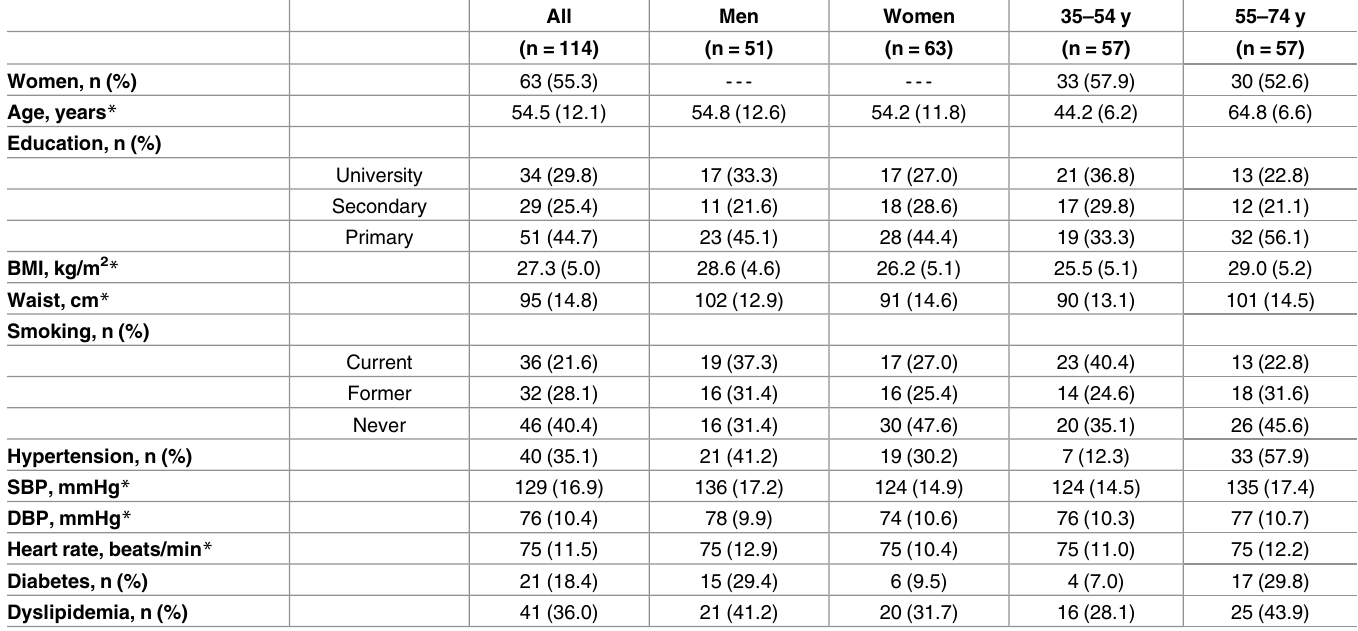
Table 2. Sociodemographic and clinical characteristics of study participants.